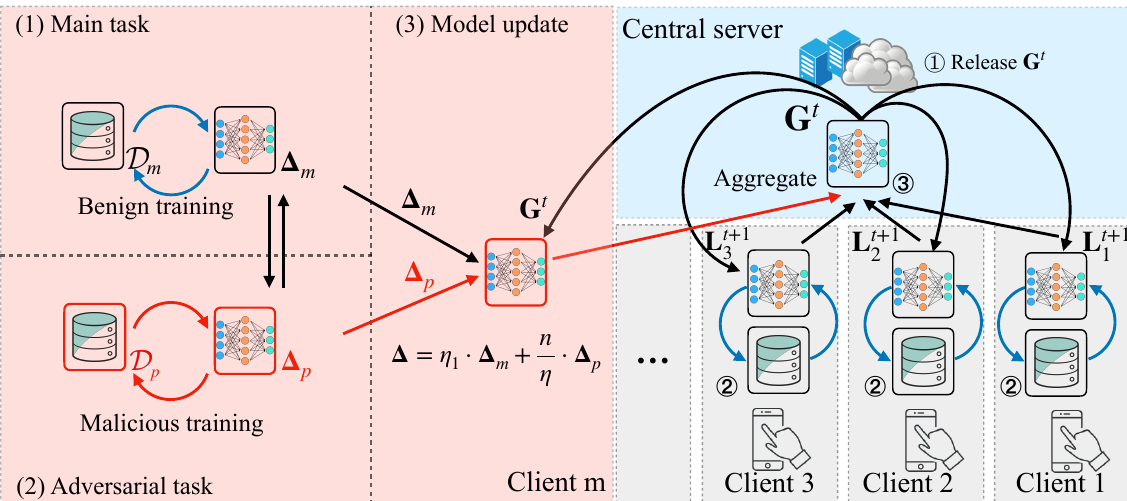
Figure 2. Overview the pipeline of deep model poisoning attack. The adversary alternately trains a mini-batch of D m and D p for a main task and adversarial task, respectively. Finally, the adversary boosts the poisoning model update ∆ p to the central